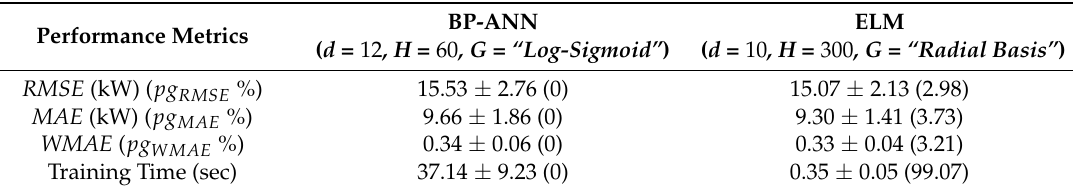
Table 3. Average performance metrics and their standard deviations obtained by the developed BP-ANN model on the test dataset, with respect to the proposed